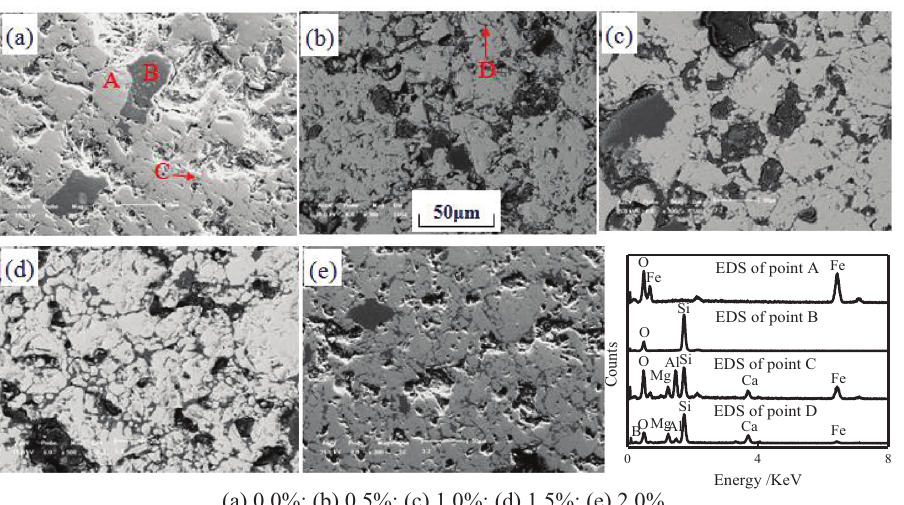
Figure 2: SEM and EDS of pellets with different content of boron mud after roasting at 1,523K (a) 0.0%; (b) 0.5%; (c) 1.0%; (d) 1.5%; (e) 2.0%.